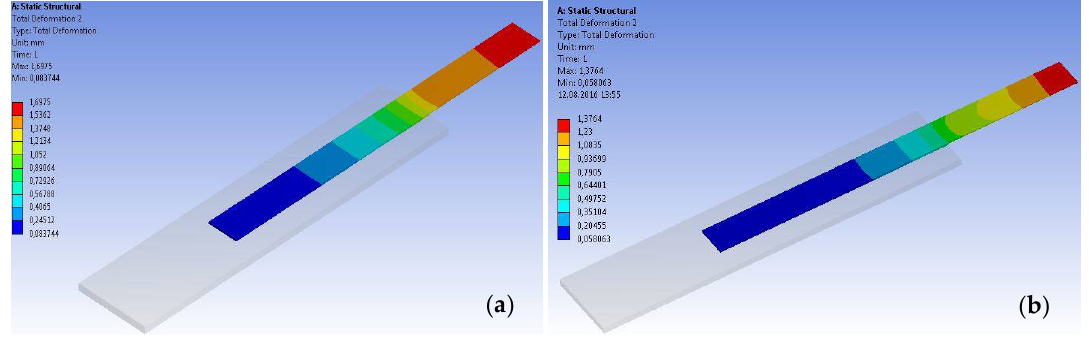
Figure 19. Displacement map at the level of the CFRP strip: ( a ) S-S512-30-1 ( b ) S-M514-30-2.